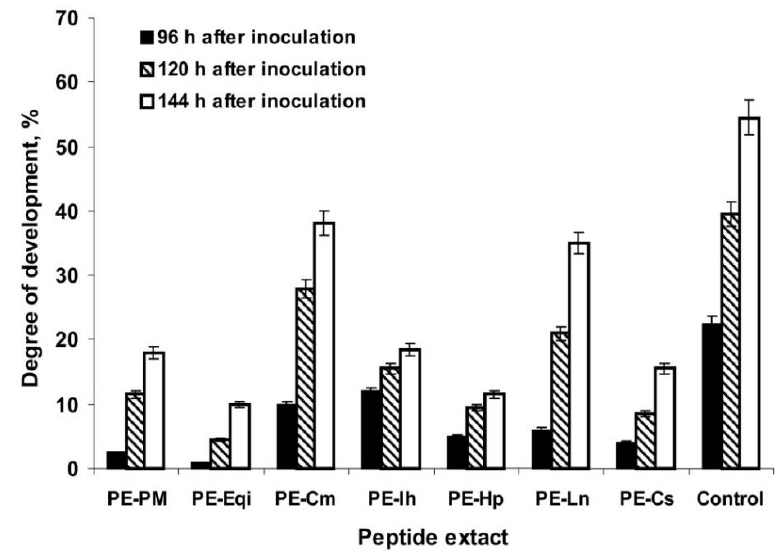
Figure 2. Antimicrobial activity of the plant peptide extracts against P. infestans by inoculation of potato tuber slices.